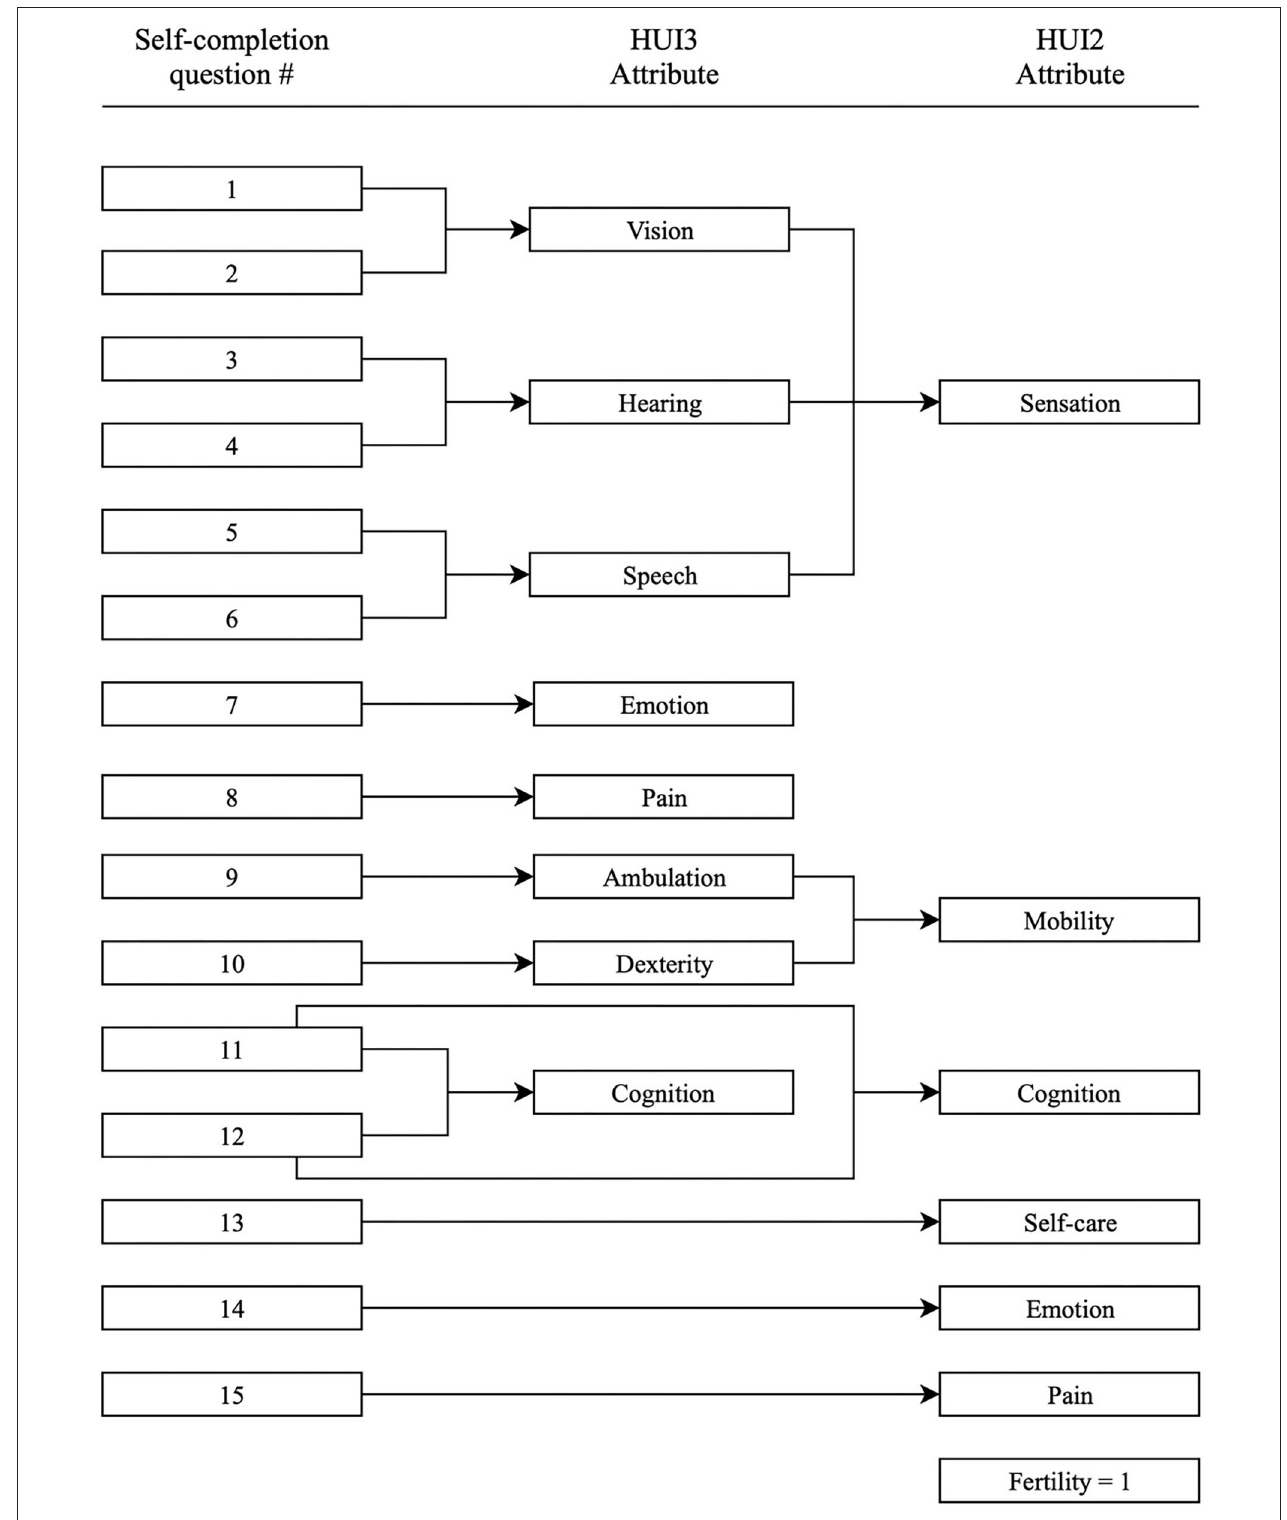
FIGURE 1 | Specification of questions used to derive HUI3 and HUI2 attribute levels.